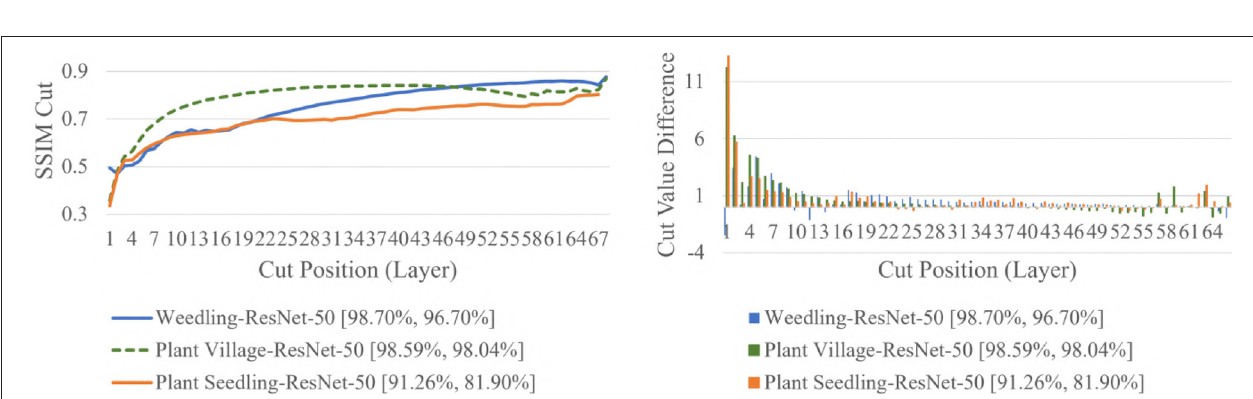
convolutional layers. Examining the features extracted by the convolutional layers, it is evident that for the ResNet-50 model after a certain depth, GBP visualizations are similar. However, for the 2-Conv-ResNet, and both shallow models, the GBP visualizations were dissimilar across all the layers. To quantify SSIM cut curve. For every class in a dataset, we randomly